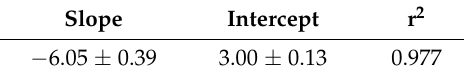
Table 2. Slope, intercept and coefficient of determination for the oxidation states vs. K-M calibration curve.